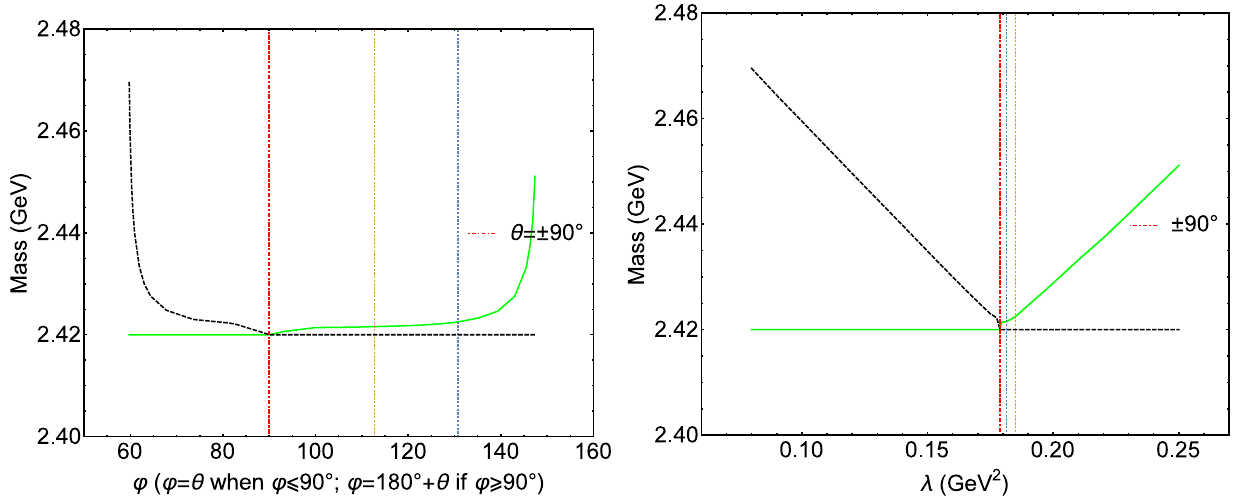
Fig. 4 The masses of D 1 ( 2420 ) (black dashed line) and D (cid:3)